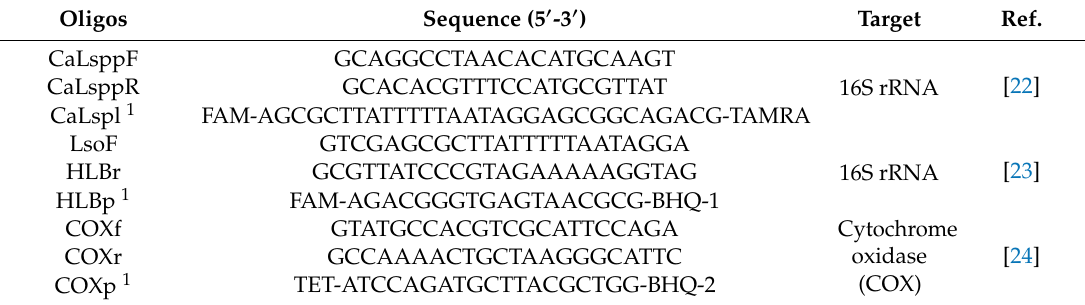
Table 2. Primers and Probes Used for qPCR Reactions to Specifically Detect CLso and the Endogenous Plant Gene, Cytochrome Oxidase (COX) in Samples of Leaves, Roots, Seeds or Potato